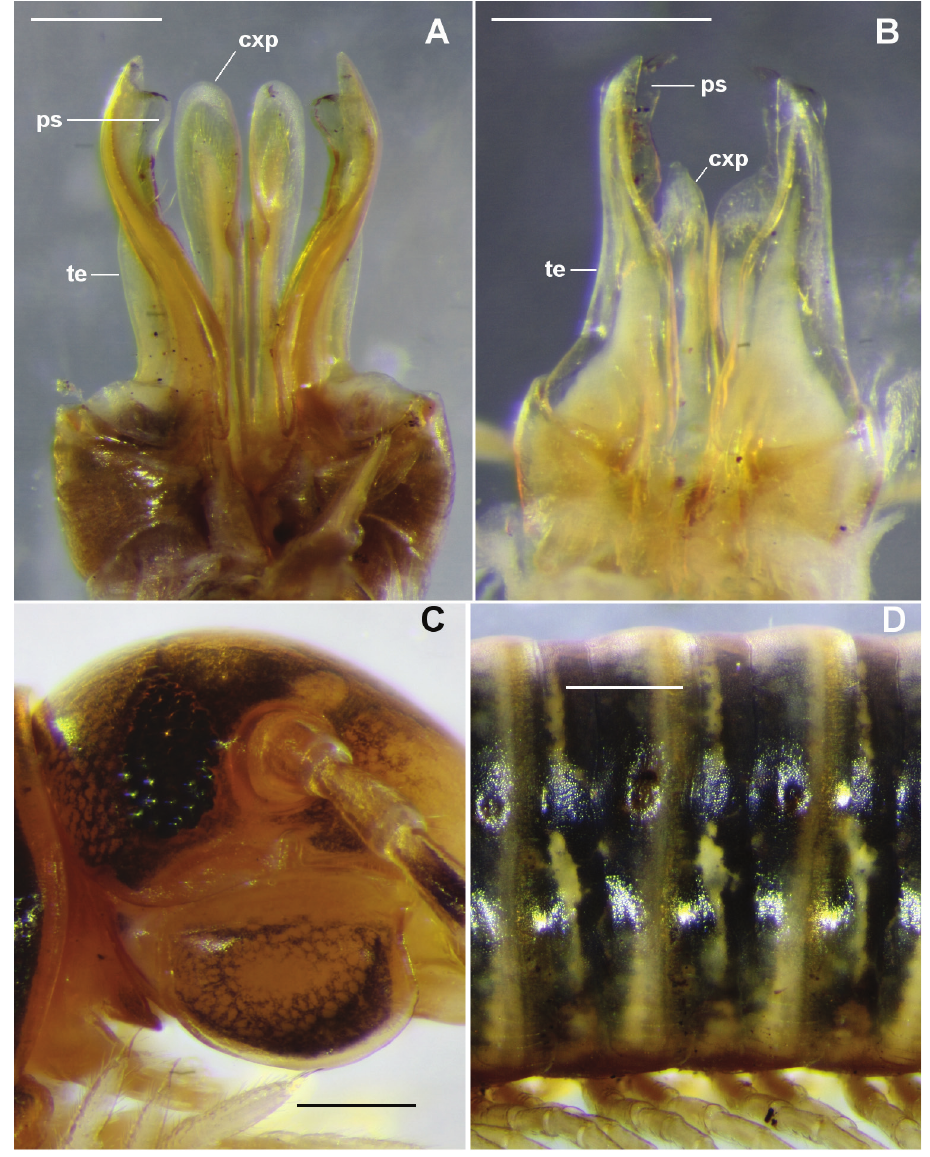
Figure 1 . A Amastigogonus tasmanianus Brölemann, 1913 (type species of Amastigogonus ), QVM 23:54404 B–D A. insularis sp. n., holotype, QVM 23: 46411 A, B Posterior views of gonopod complex; C right lateral view of head D left lateral view of midbody rings cxp coxite process ps pseudoflagellum te telopodite. Scale bars = 0.5